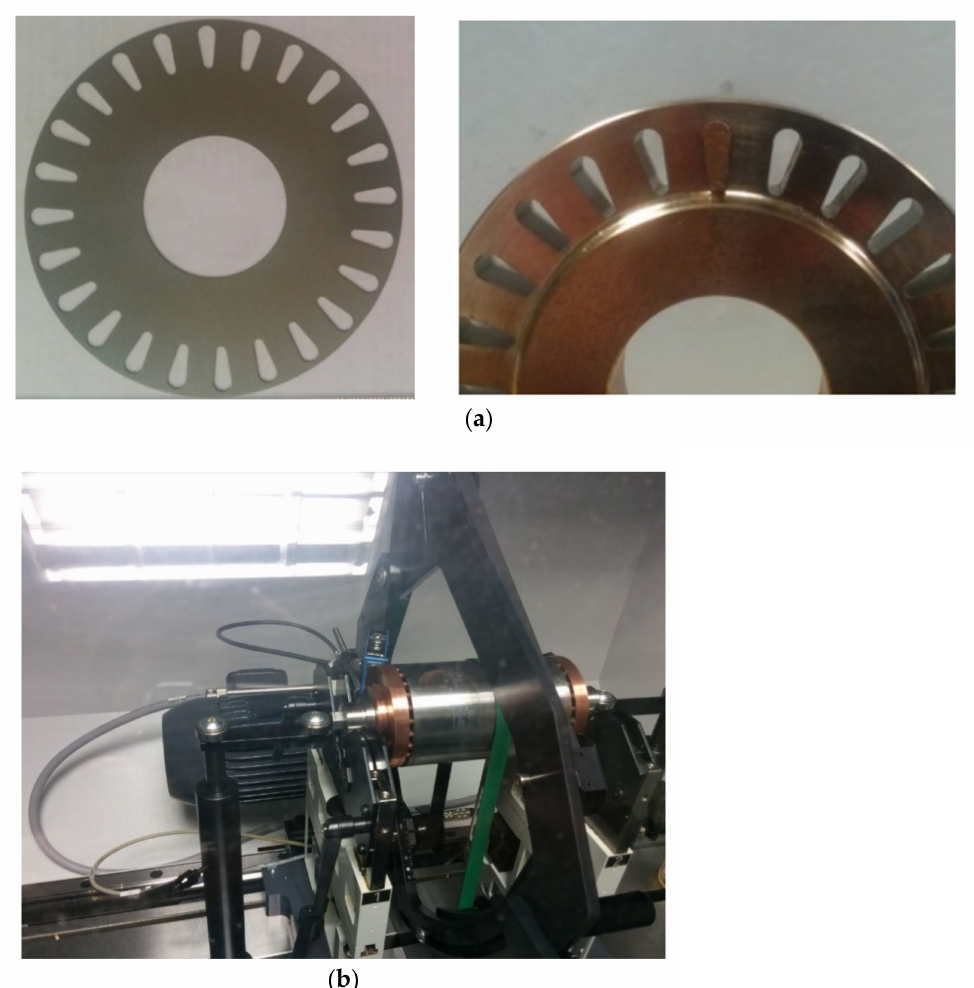
Figure 15. Prototyped high-speed induction machine for marine EAT application ( a ) lamination profile, ( b ) precision balancing of high-speed rotor assembly.